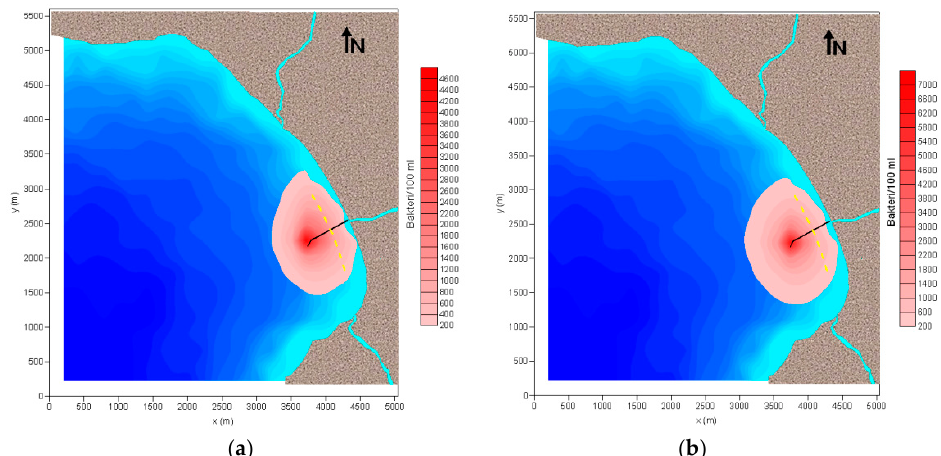
Figure 14. Distribution of the pollutant cloud caused by the wind blowing from WSW at: ( a ) 10 m/s and ( b ) 2 m/s [33].